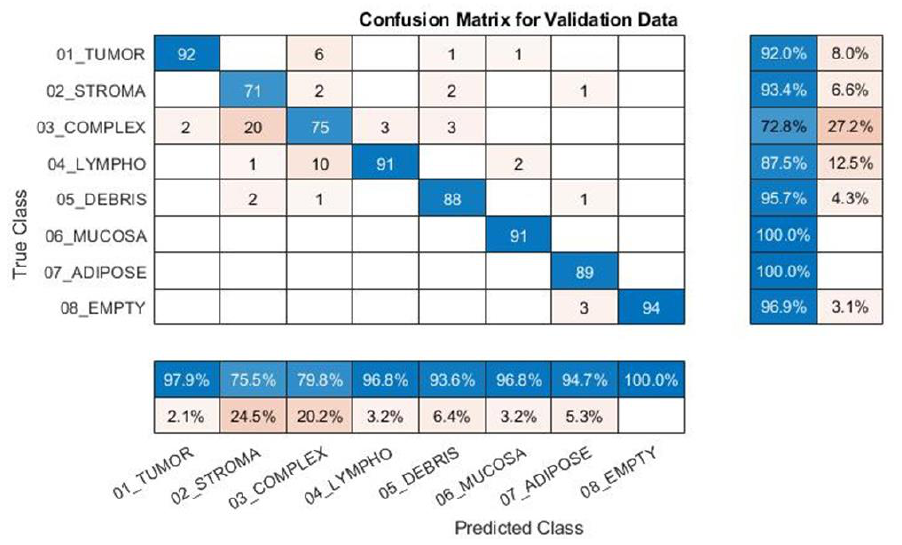
Figure 6. Experiment I: the accuracy of eight classes (Kather-texture-2016-image-5000). Table 4. Experiment I: the best results of eight tissue classes (Kather-texture-2016-image). Accuracy Rate (%)